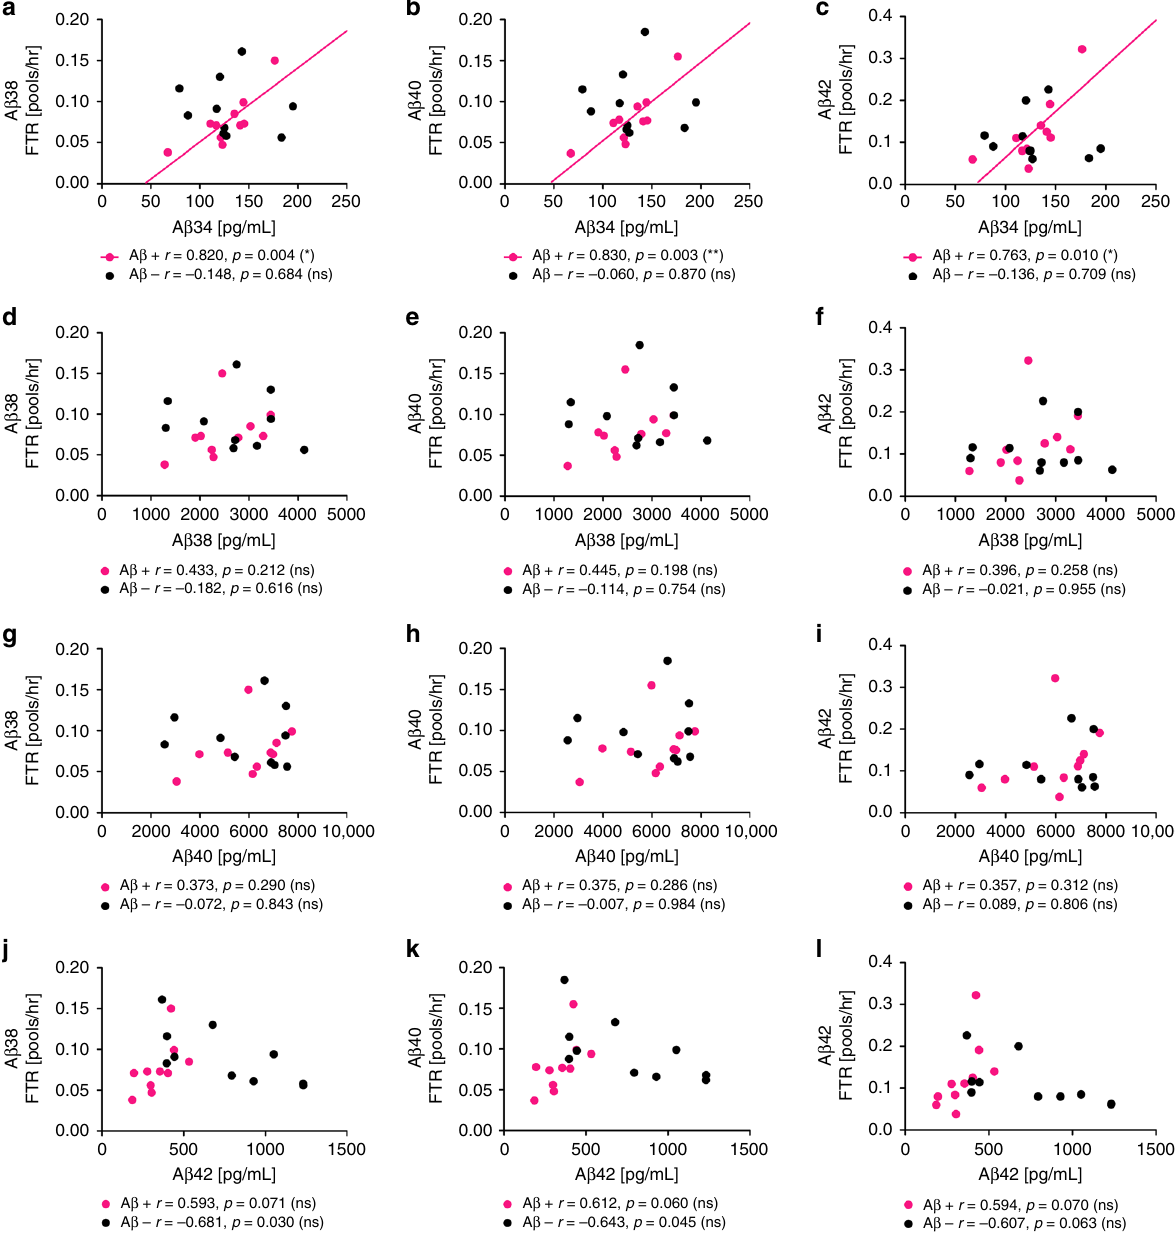
Fig. 8 Association between CSF-A β 34 and A β clearance rates. Analysis of A β 34, A β 38, A β 40, and A β 42 in human CSF with ultra-sensitive assays (Meso Scale Discovery (MSD)). A β 38, A β 40, and A β 42 clearance (fractional turnover rate, FTR) was previously measured using stable isotope labeling kinetic (SILK) 31 . Samples were from n = 10 A β + and n = 10 A β – individuals. Scatterplots of CSF-A β 34 ( a – c ), A β 38 ( d – f ), A β 40 ( g – i ), or A β 42 ( j – l ) with A β 38 FTR ( a , d , g , j ), A β 40 FTR ( b , e , h , k ), or A β 42 FTR ( c , f , i , l ). Pearson correlation coef fi cients ( r ) were computed to assess the relationship between the variables. The Bonferroni adjusted p -values are: ** p < 0.003, * p < 0.016, ns = nonsigni fi cant p >